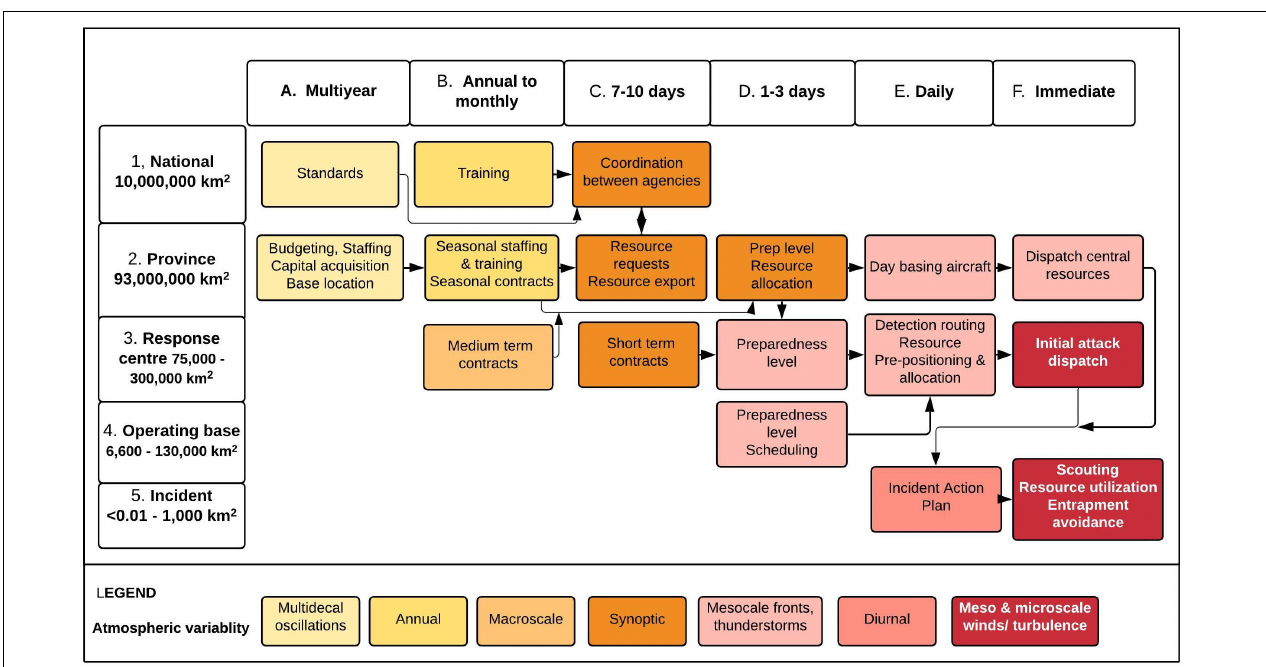
FIGURE 7 | An N-2 chart of typical situation spaces in fire management decision making in the province of British Columbia, Canada, and influences of atmospheric